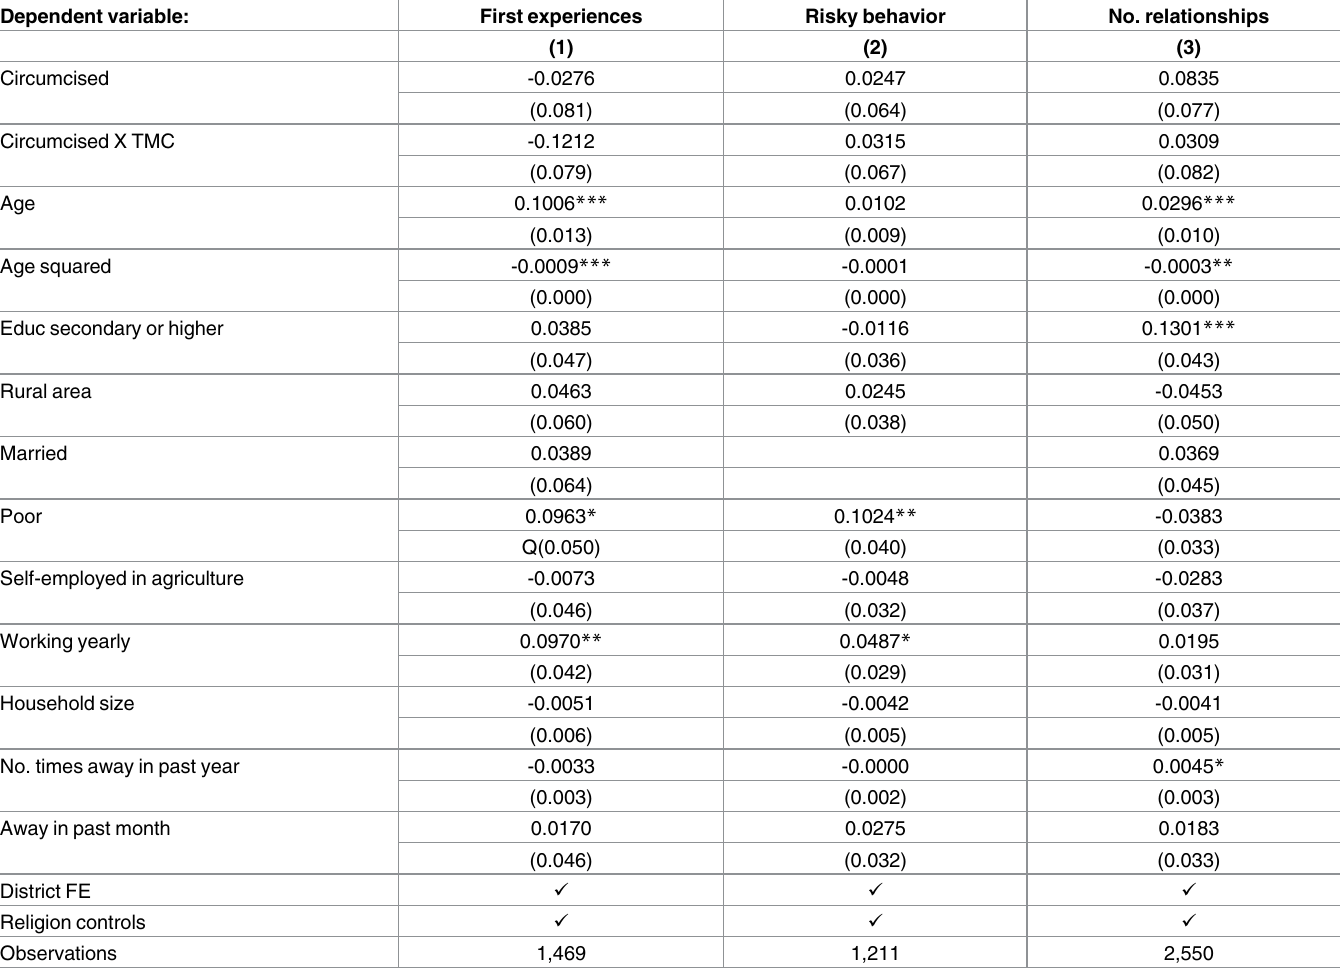
Table 5. Male circumcision and indexes of risky sexual